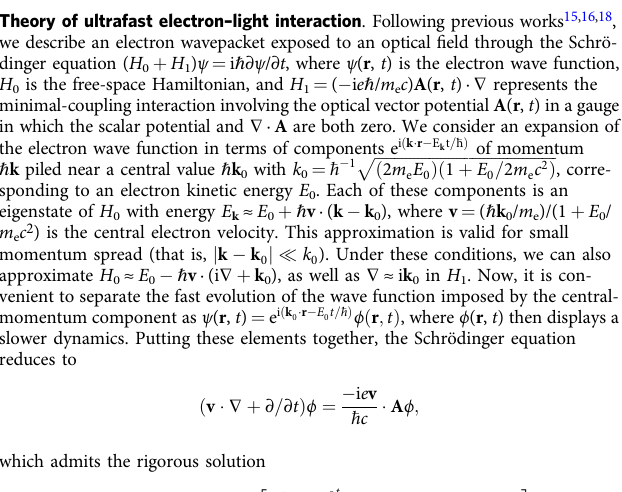
durations τ e and τ L , respectively). For infrared pulses with τ L = 60, 175, and 430fs FWHM, we derived electron pulse durations τ e = 350, 395, and 410fs